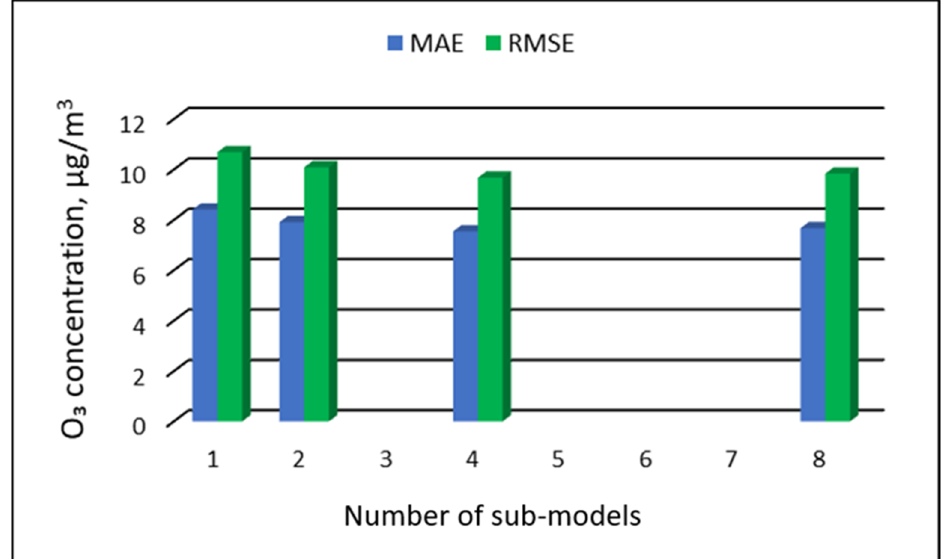
Figure 6. Overall MAE and RMSE values for O 3 concentration prediction in PVS models depending on the number of created sub-models, Z ł oty Potok. Table 5. Values of approximation errors of O 3 concentrations in RVS models, Zabrze 2011–2016.